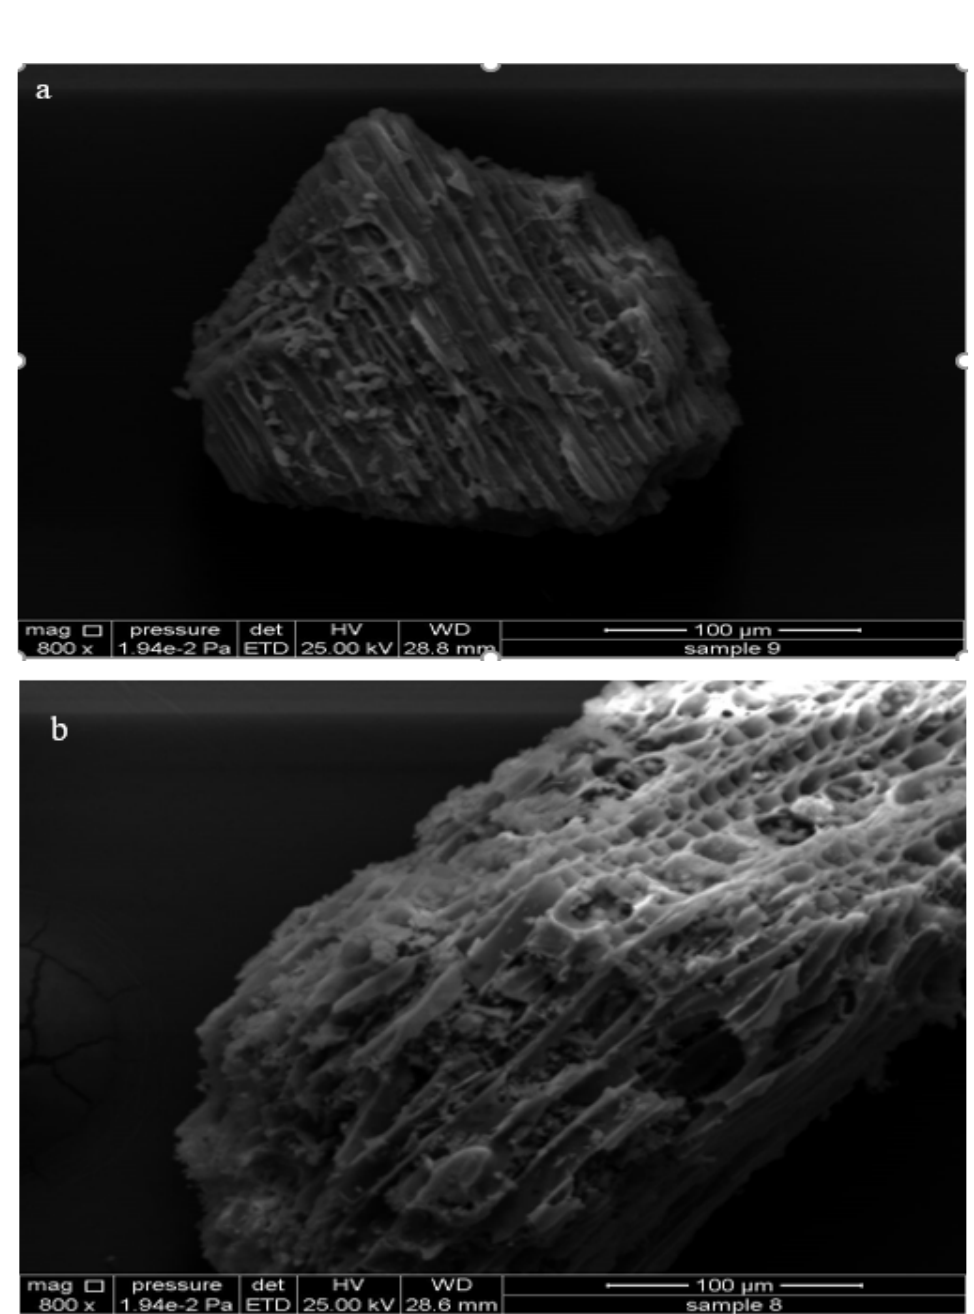
Figure 1. SEM images of ( a ) biochar (BC) and ( b ) acidified biochar (ABC).